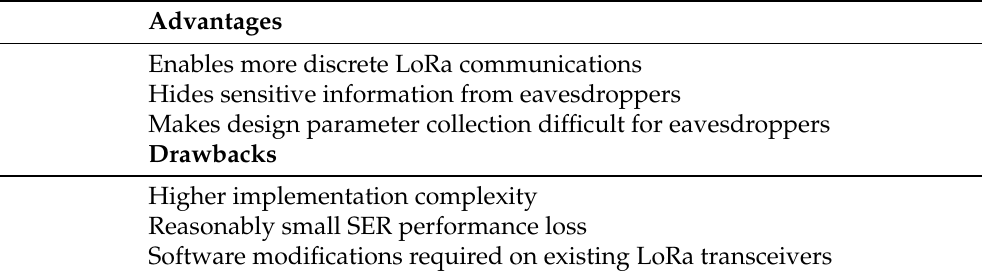
Table 6. Advantages and drawbacks of the LoRa self-jamming scheme.